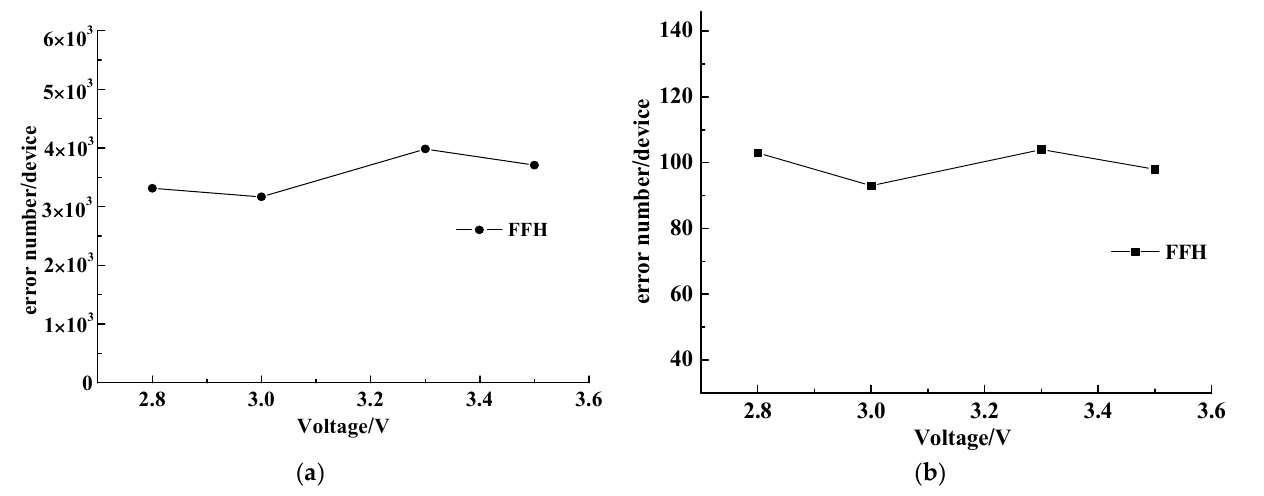
Figure 12. Error numbers of the SRAM as a function of bias voltages for SEE ( a ); and SESD ( b ).